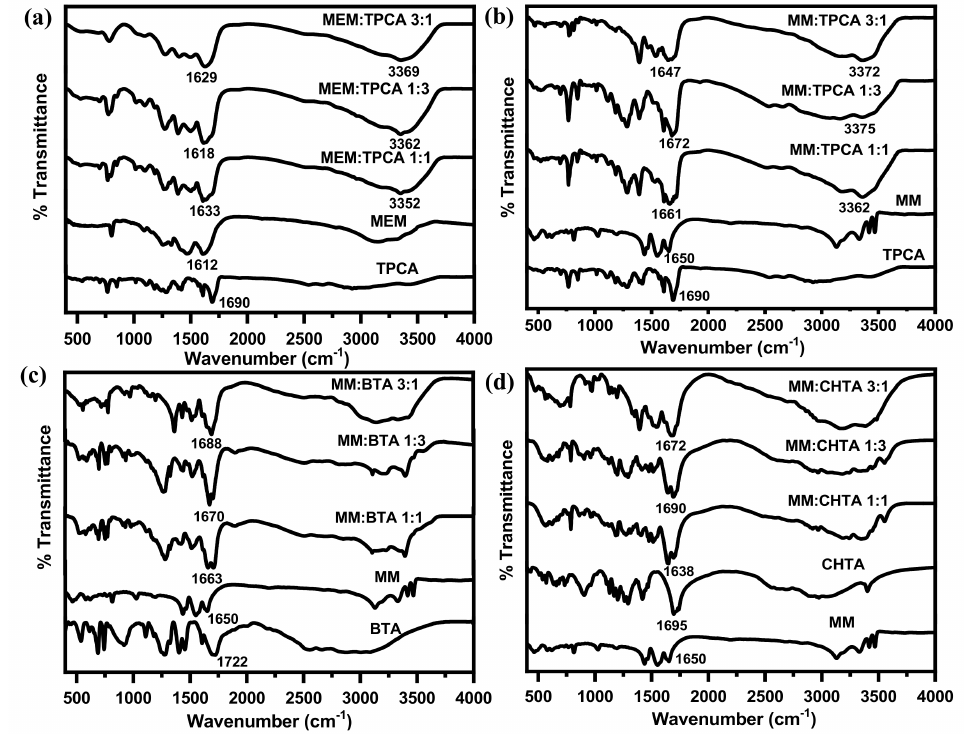
Figure 4. FTIR spectra of ( a ) MEM–TPCA, ( b ) MM–TPCA, ( c ) MM–BTA and ( d ) MM–CHTA hydrogel network at three different molar ratios and individual components (MM, MEM, TPCA, BTA and